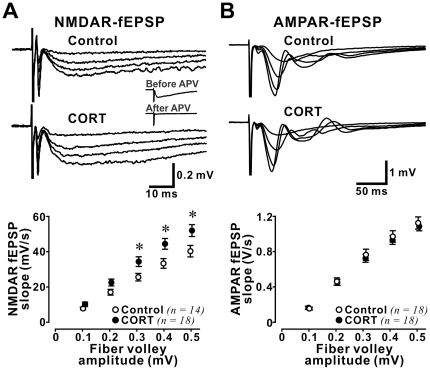
Stress level CORT increased NMDAR-mediated fEPSP in the adult hippocampus.(A) Upper panel: representative average traces of evoked field excitatory postsynaptic potentials (fEPSP) mediated by NMDAR. Strength of stimulation was adjusted to produce fiber volley sizes ranging from 0.1 to 0.5 mV. Inset: Traces of NMDAR-mediated fEPSPs measured before and after APV treatment (50 µM). Note that fEPSP but not the fiber volley and stimulation artefact was abolished by APV. Lower panel: Plots of the relationship between fiber volley size and fEPSP slope in both control and CORT-treated hippocampal slices. Note that CORT significantly increased NMDAR-fEPSP at fiber volley size of 0.3-0.5 mV. * p<0.05: post-hoc Fisher's test after ANOVA. (B) Upper panel: representative average traces of AMPAR-fEPSP. Lower panel: Plots of the relationship between fiber volley size and AMPAR-fEPSP slope. No difference was observed between these parameters in control and CORT-treated slices.